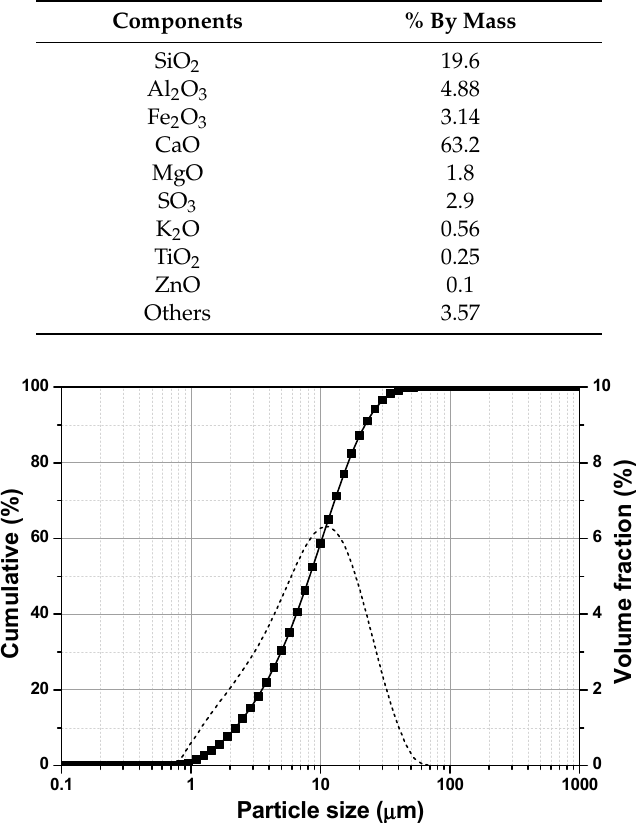
Figure 1. Particle size distribution of the Portland cement.